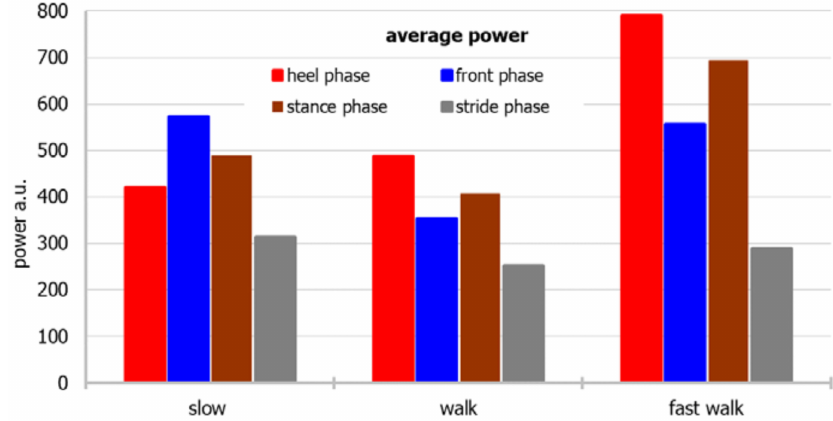
Figure 5. Mean power according to different modes of movement.